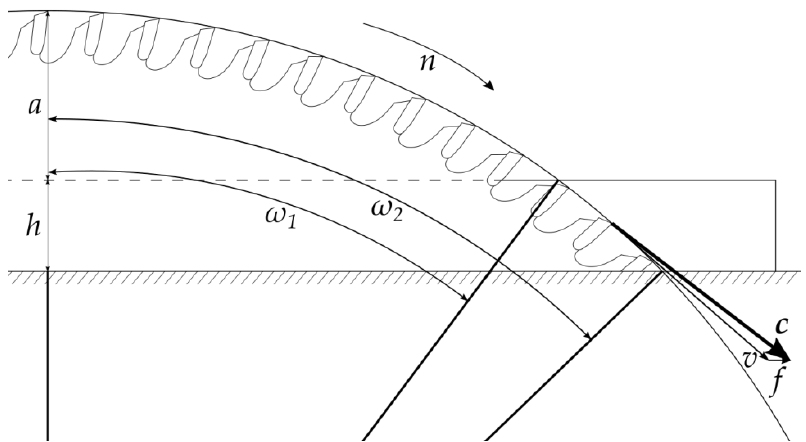
Figure 1. Sawing experiment setup: a —saw projection beyond the workpiece, h —thickness of par- ticleboard, ω 1 —saw enter angle, ω 2 —saw exit angle, n —rotation of saw, c —peripheral velocity of saw (tooth), f —feed rate, v —real cutting velocity.